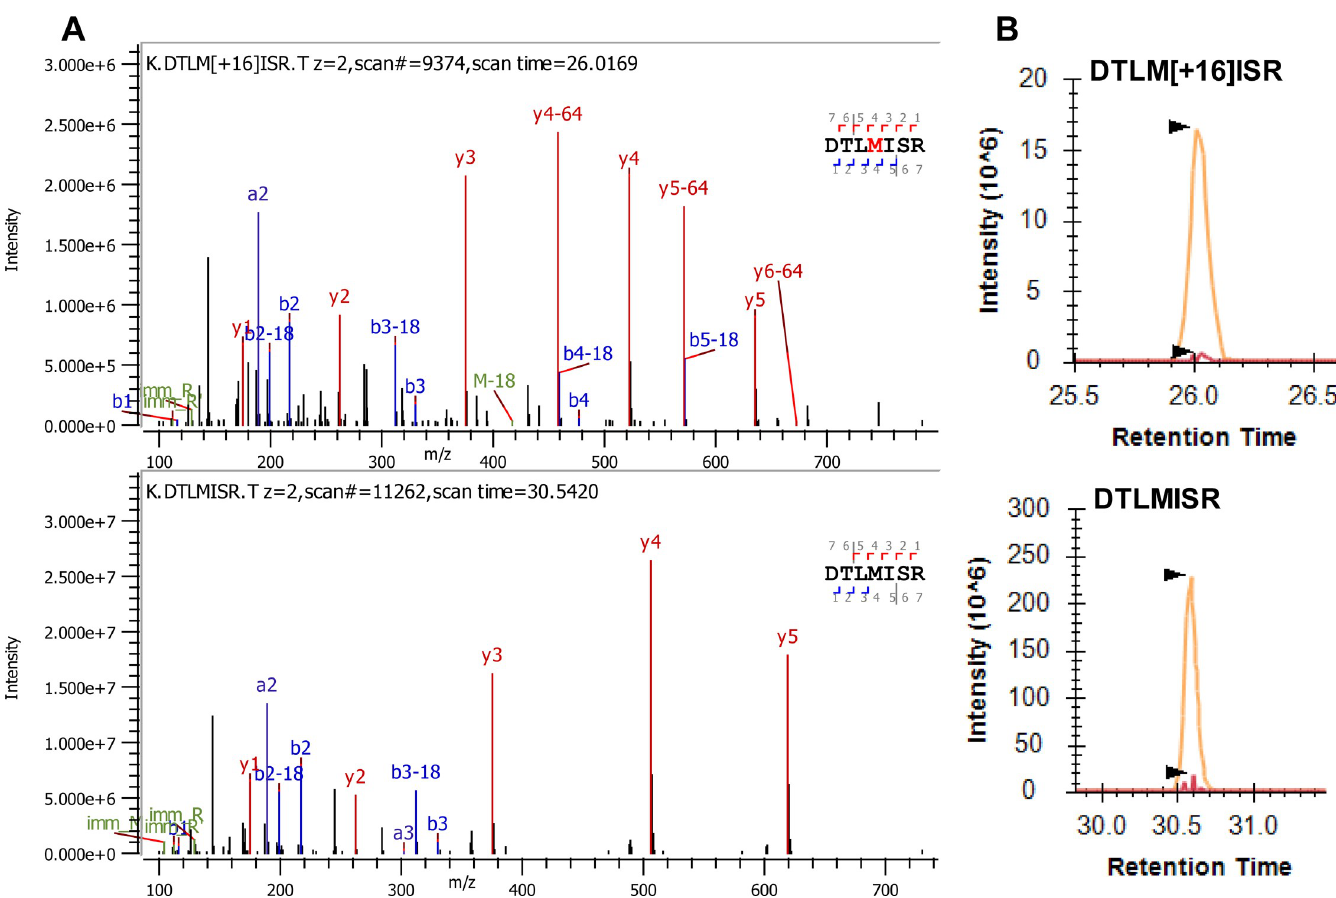
Fig 2. Example MS/MS spectra of peptide identification (A) and example extracted ion chromatograms for peptide peak integration and PTM quantitation (B). (A) The MS/MS spectrum of an example Met oxidized (Met site 1) peptide, DTLMISR (top panel) and the MS/MS spectrum of the example wild-type peptide, DTLMISR (bottom panel). (B) Extracted ion chromatograph of the Met oxidized peptide, DTLMISR (top panel) and the wild-type peptide, DTLMISR (bottom